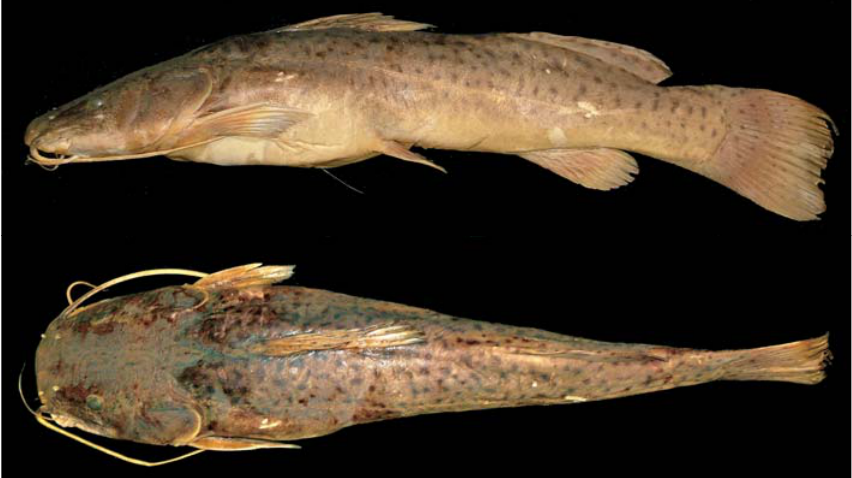
Fig. 3 . Lateral and dorsal views of S. amblyurum . MZUSP 87986, 334 mm SL, Almenara, rio Jequitinhonha, ilha Bela Vista, Minas Gerais,